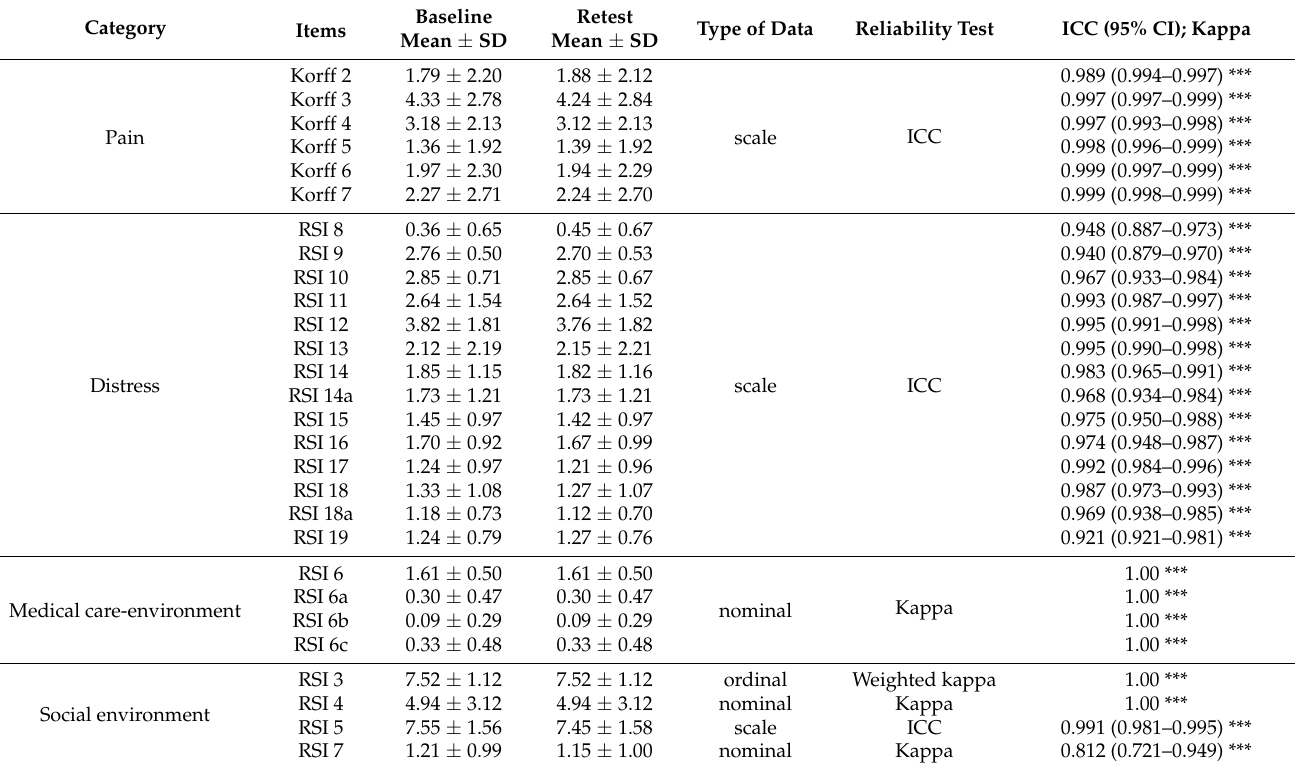
Table 3. Test-retest reliability for each